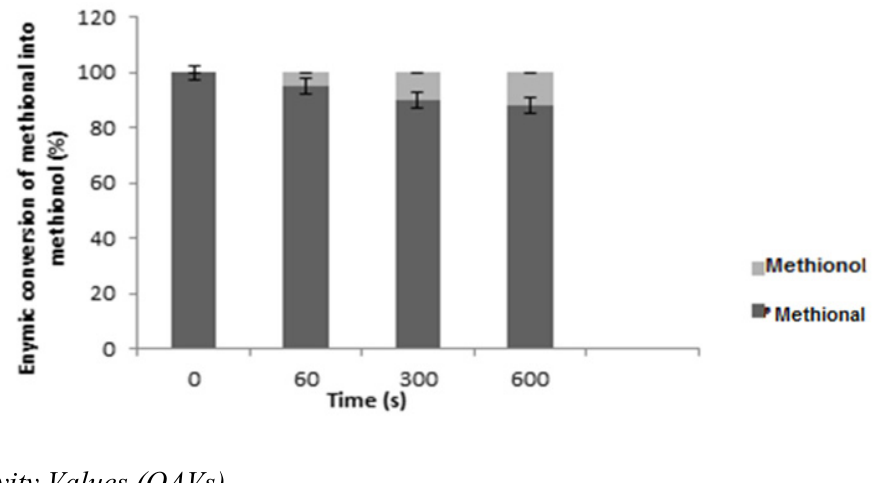
Figure 2. The conversion of palm wine methional to methionol during incubation with saliva at different time intervals [60, 300 and 600 s]. Initial concentration of methional = 100 µg/L. values are the means of three replicates. Error bars show the standard